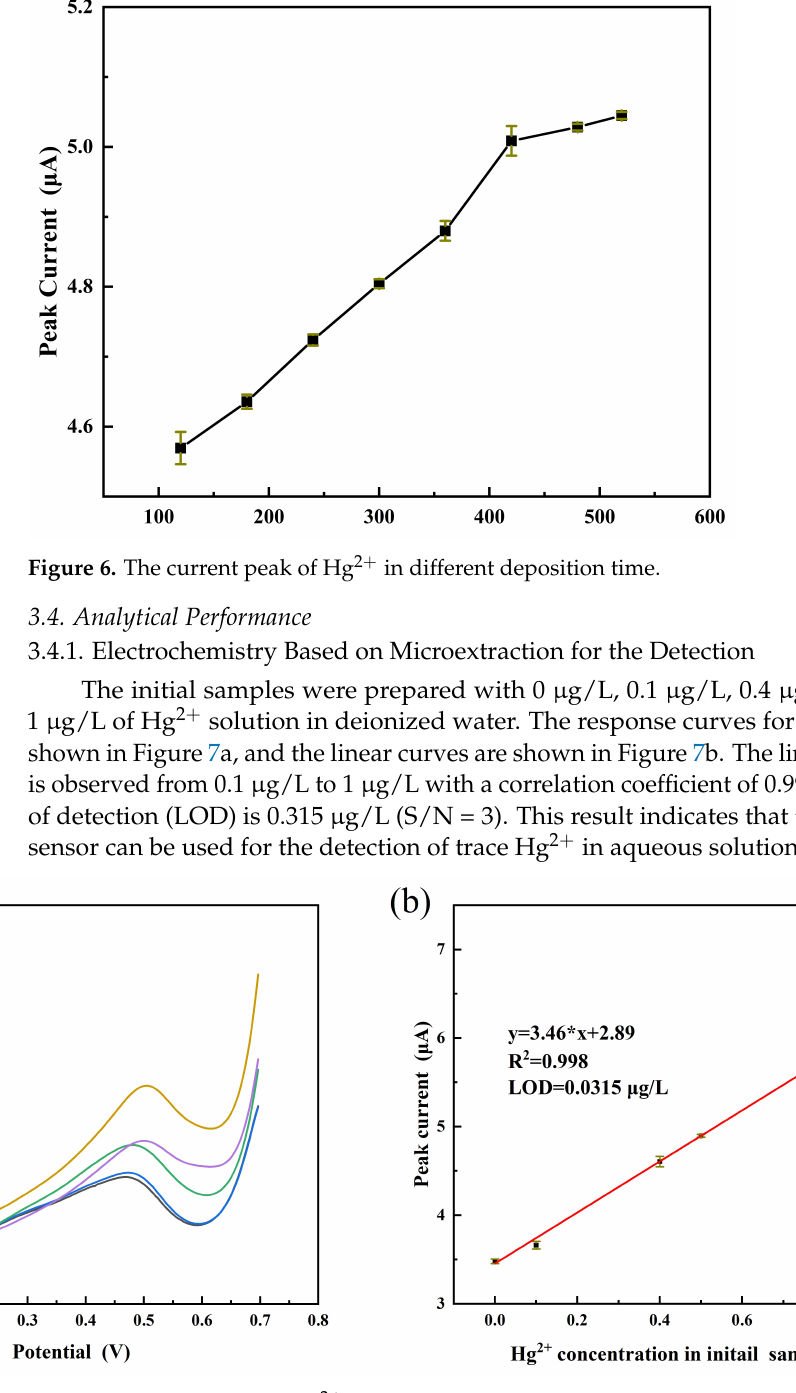
Figure 7. ( a ) current response of different Hg 2 + concentrations; ( b ) liner response curve to Hg 2 +